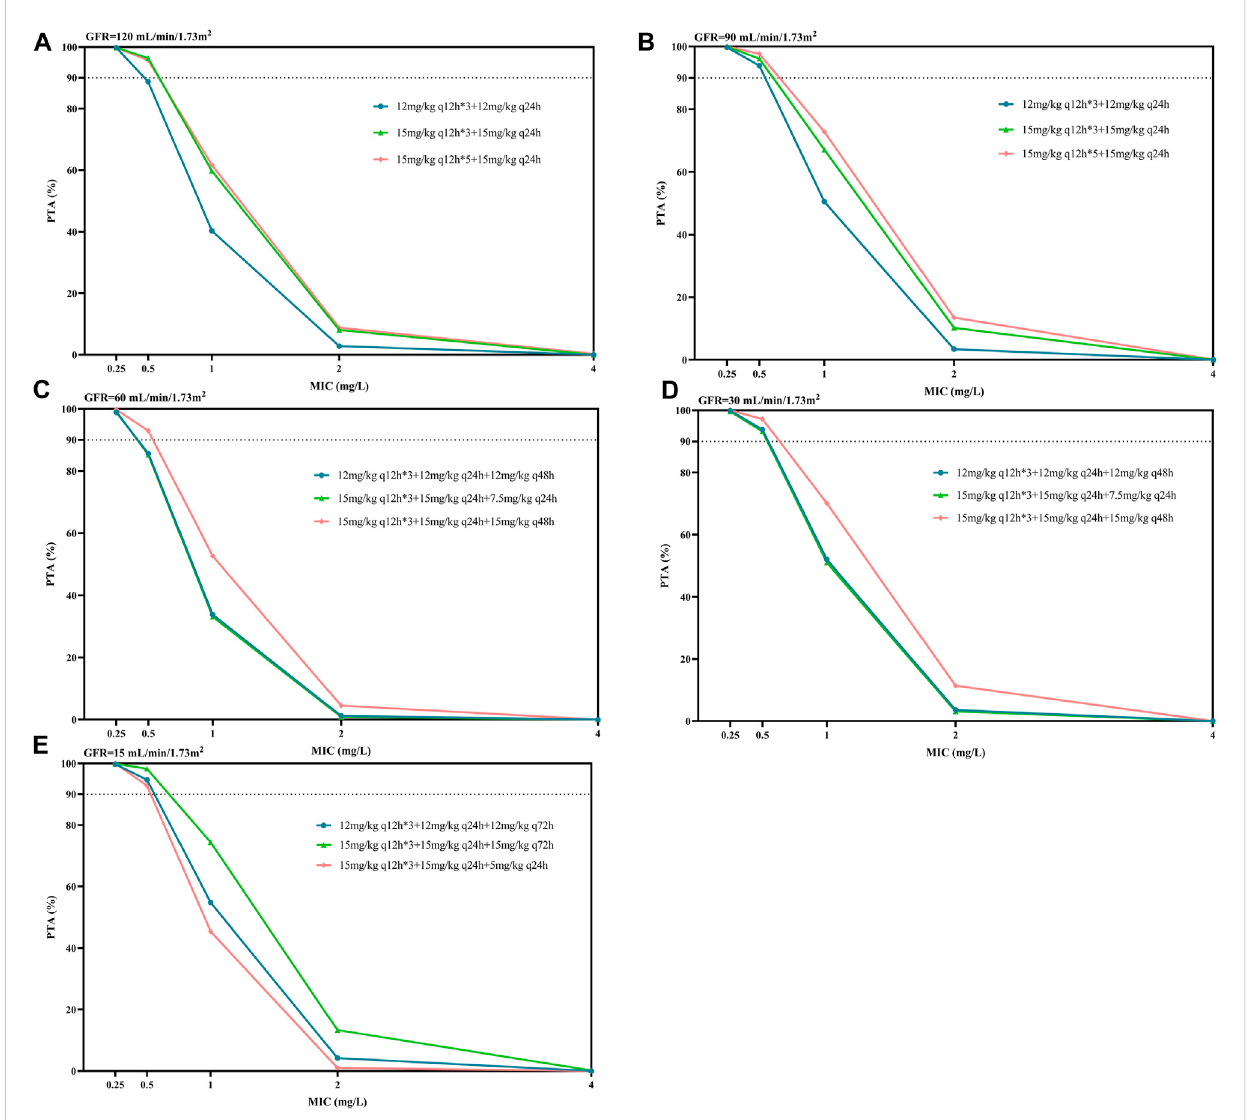
FIGURE 4 PTAofteicoplaninagainst MRSAforthetargetofAUC 0-24 /MIC ≥ 610insubgroupsstrati fi edbyGFR. (A – E) representsubgroupswithGFRof120,90, 60, 30 and 15 mL/min/1.73m 2 , respectively. The dashed black line indicates the target PTA of